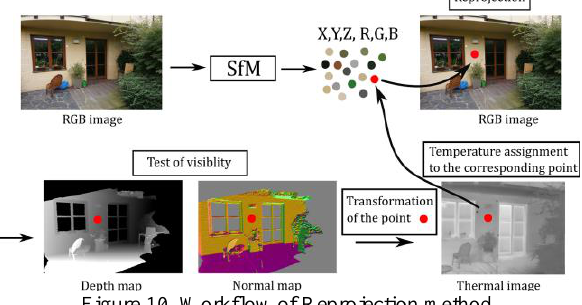
Figure 10. Workflow of Reprojection